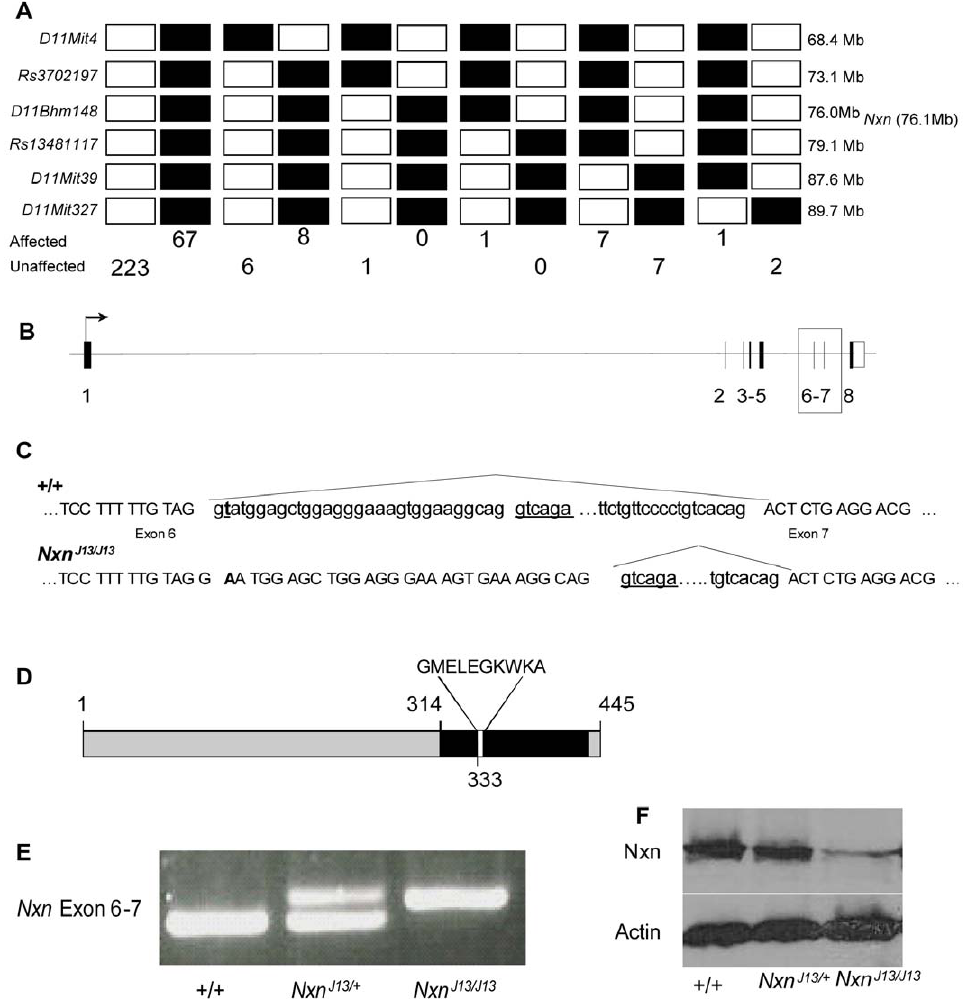
Figure 3. Mutation of nucleoredoxin in l11Jus13(Nxn J13/J13 ) . (A) Haplotype map of 239 unaffected and 83 affected mice used for meiotic mapping. The location of each marker and Nxn is displayed (Ensembl v52). The mutation lies in a 6Mb region located between rs3702197 and rs13481117 . (B) The Nxn locus is depicted with introns 6 and 7 boxed. (C) The boxed region is expanded to illustrate the consequence of splicing in the wild type and mutant. A transversion (T to A) abolishes a consensus splice donor site leading to aberrant RNA splicing. The six base pair cryptic splice site used in the mutant is underlined. (D) Aberrant splicing in Nxn J13/J13 predicts an in frame insertion of 10 amino acids, GMELEGKWKA, (white), which occurs within the acidic region (black) of Nxn. (E) RT–PCR using primers flanking exon 6–7 from pools of three E14.5 heads of wild-type, heterozygous, and homozygous mutants demonstrates aberrant splicing in the mutant allele. (F) Western blots of Nxn and Actin from wild-type, heterozygous and homozygous mutants at E12.5 show reduced protein in the homozygous mutant. A reduction in protein was also observed at E15.5 and E18.5, and a polyclonal antibody against the N-terminus gave similar results (data not shown).